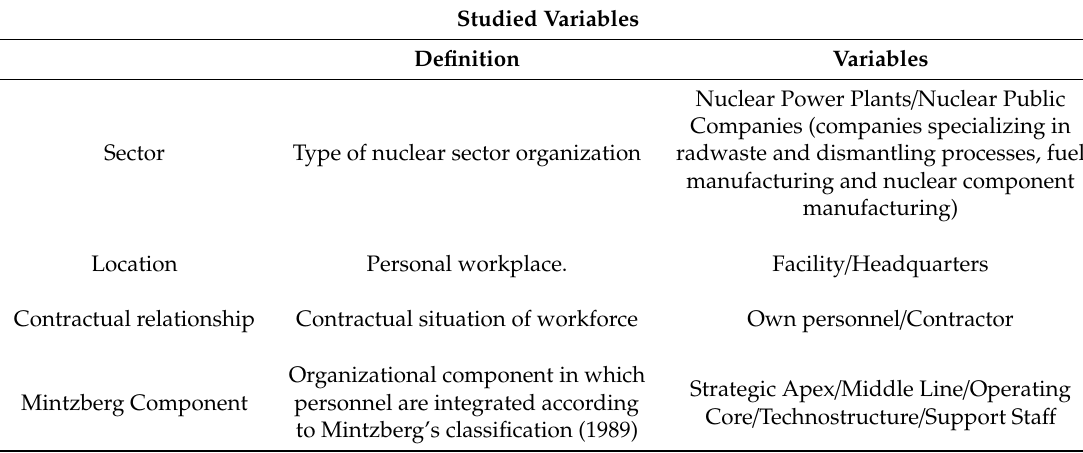
Table 3. Variables used in the comparative